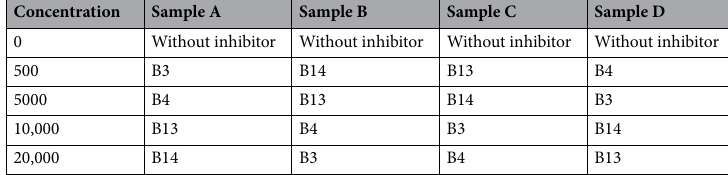
Table 3. The inhibitors and corresponding concentrations used as inhibitor